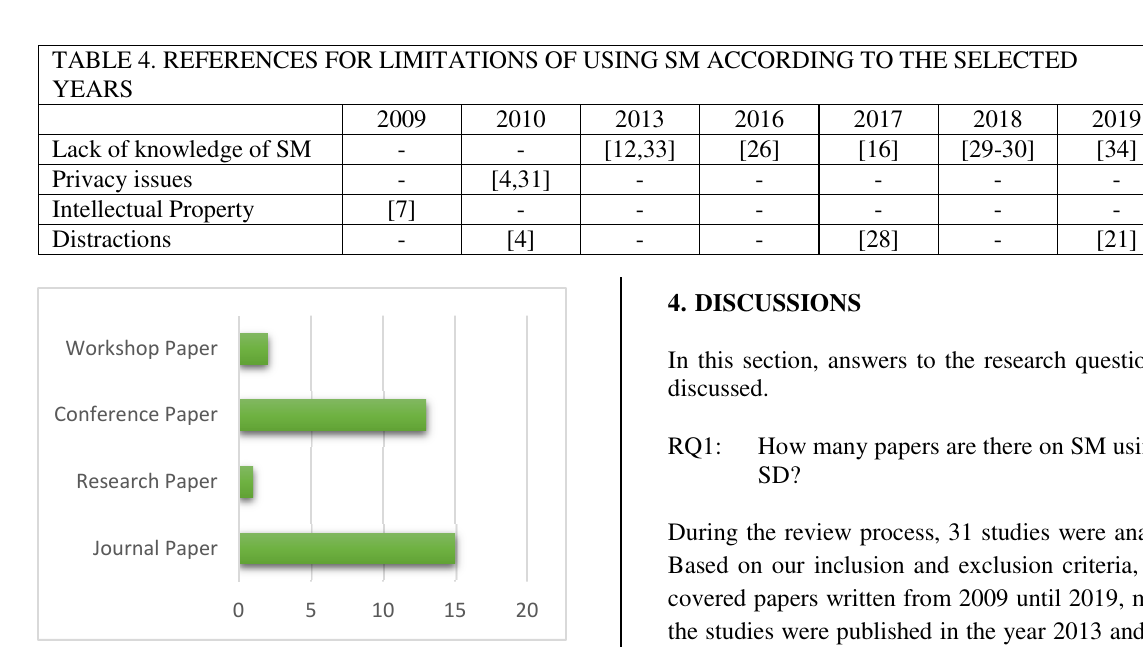
FIG. 2: TYPE OF PUBLICATIONS